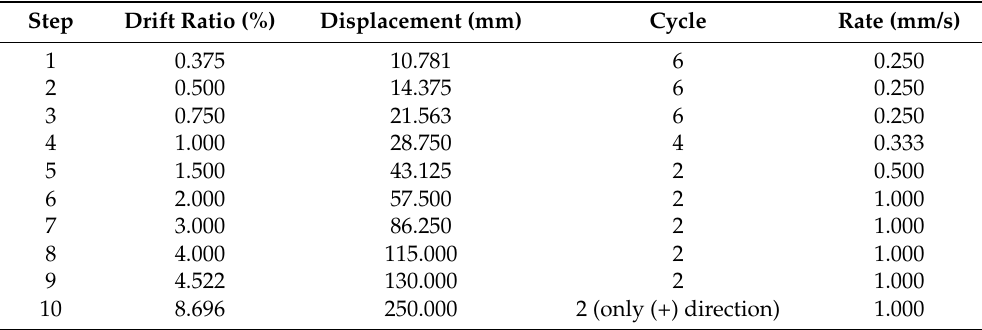
Table 4. Results of a tensile test.